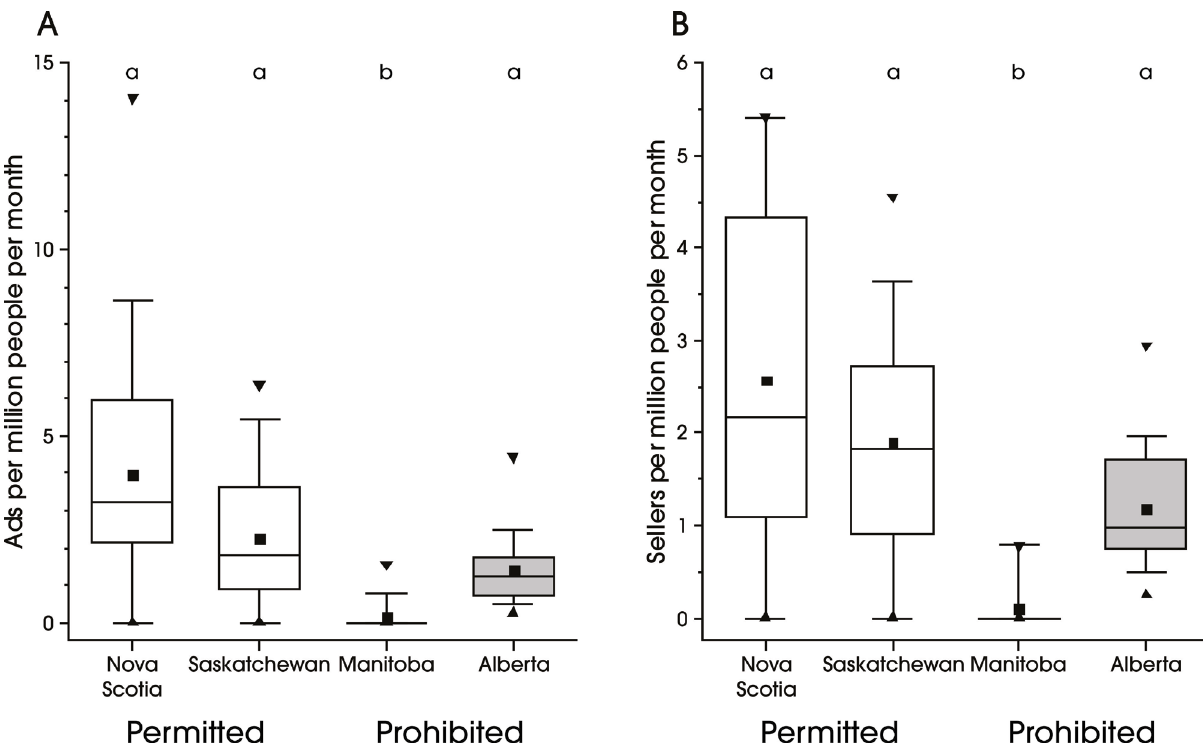
Figure 3. Online sales of crayfish in selected Canadian provinces. A, number of individual advertisements per month per million people in the population. B, number of individual sellers placing ads per month per million people in the population. In both, provinces that do not differ statistically share a lowercase letter above the box. Square = mean; horizontal line = median; box = 50% of data; whiskers = 95% of data; triangles = minimum and